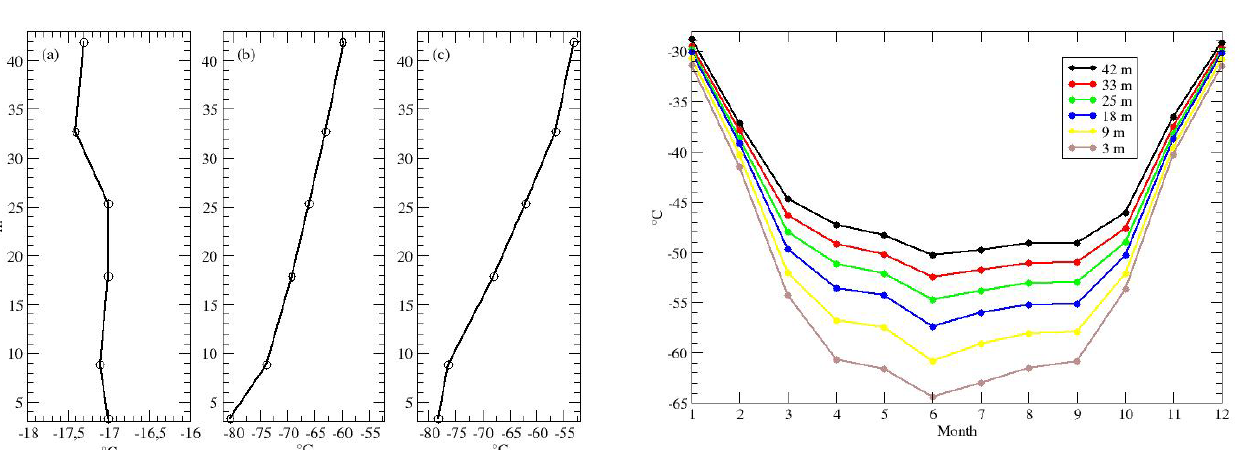
Figure 3. Vertical profile of daily-mean temperature on 2 January 2014 (a) , 22 June 2017 (b) and 24 June 2017 (c) , the days with the warmest and coldest temperatures and the steepest temperature inversion, respectively.